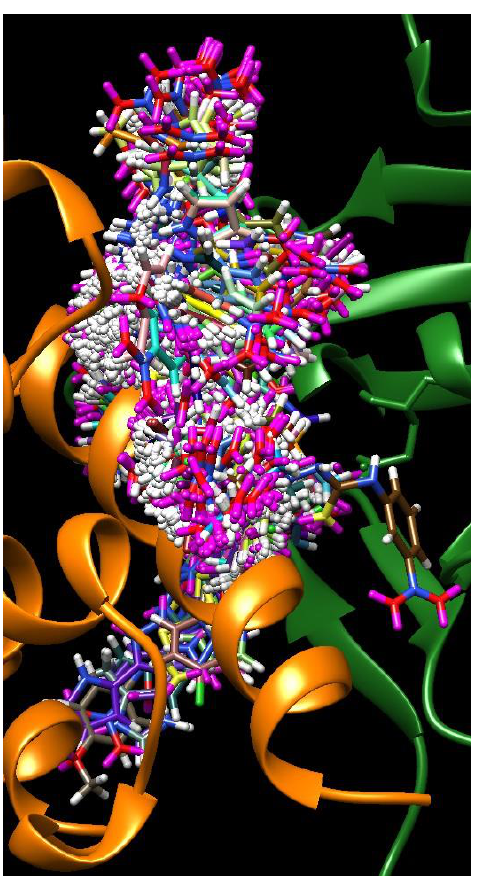
Figure 6. Overlay of the 10 best binding poses of all studied compounds in the groove of the S-protein–ACE2 receptor interface (for color code, see Figure 4).